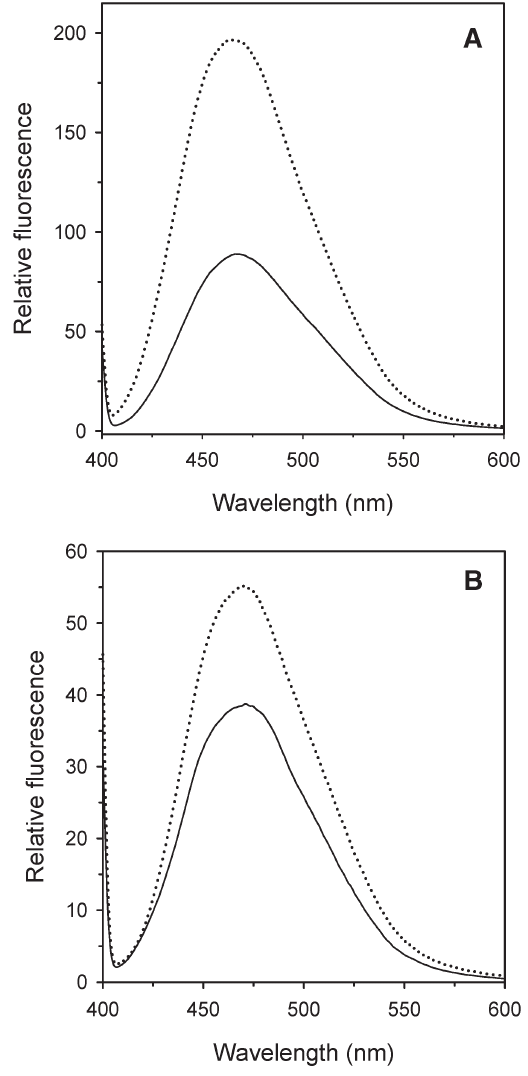
Figure 4. Relative accessibilityof hydrophobic residues in Solfolobus solfataricus wild type (wt) amidase (A) and its Y41C mutant (B) monitored by the extrinsic fluorescence of 8-anilinonaphtalene-1-sul- fonicacidammoniumsalt(ANS). The ANS (25µM)wasadded tothe protein (2.5 µM), which had previously been incubated overnight at pH 8.0 (20 mM sodium phosphate, solid line) and at pH 5.0 (20 mM sodium citrate, dotted line). Fluorescence emission spectra (390 nm) were recorded at 20 °C, 10 min after the addition of ANS.